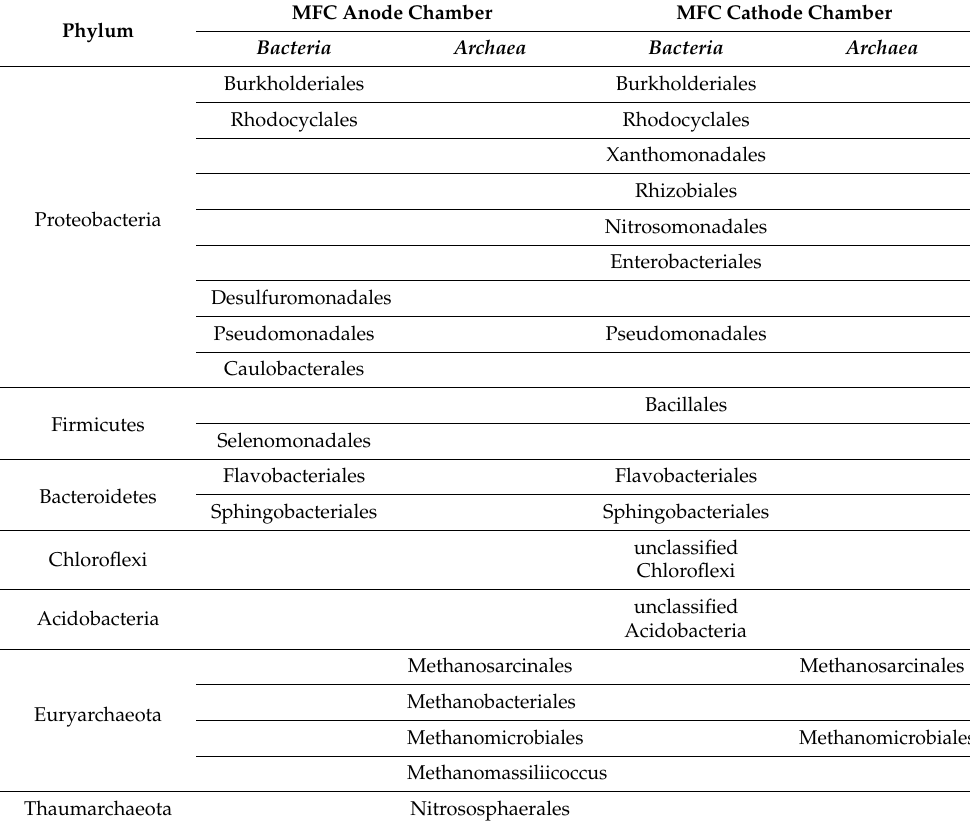
Table 2. Microbial Analysis of the Biocathode MFC